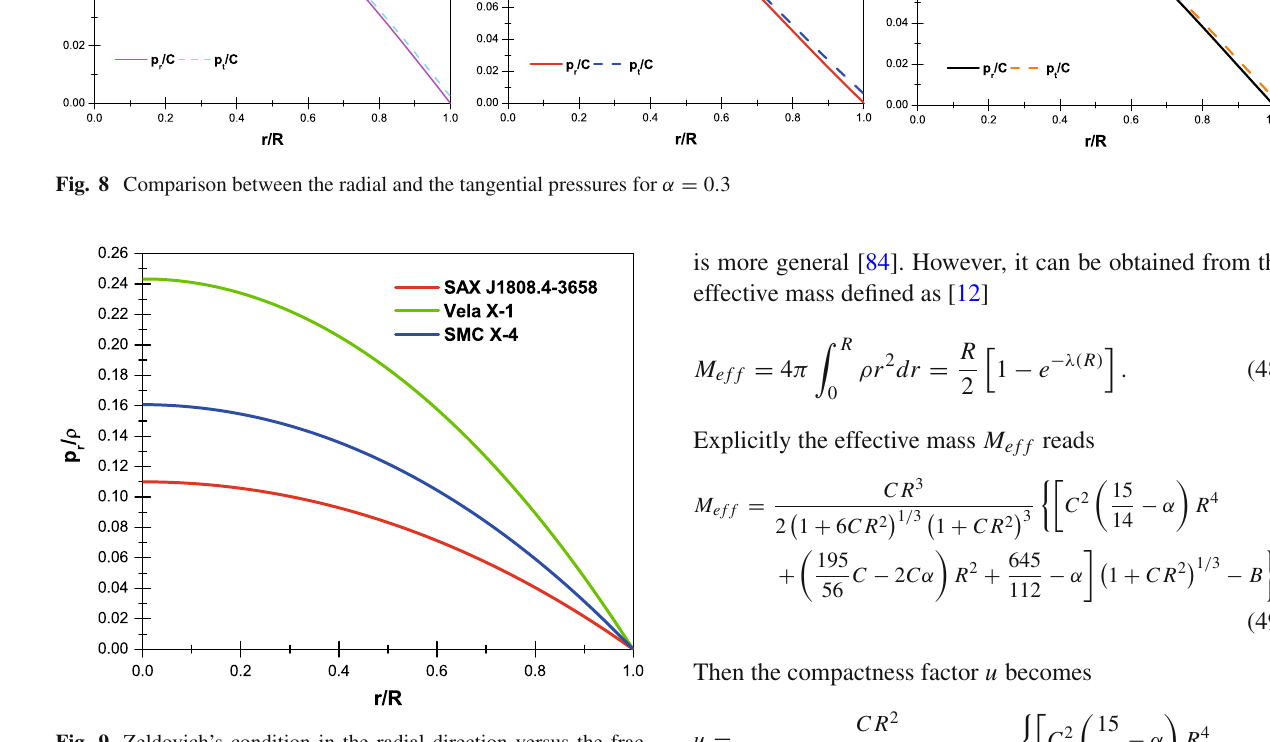
Fig. 9 Zeldovich’s condition in the radial direction versus the frac- tional radius for α = 0 . 3